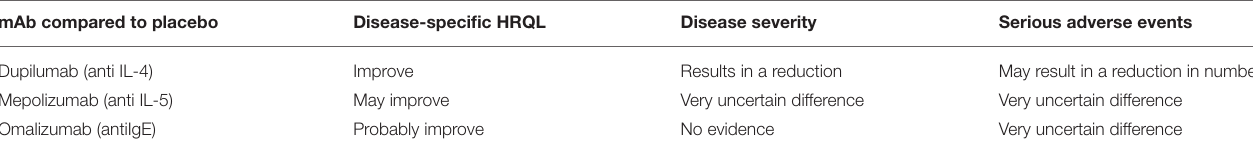
TABLE 2 | Main results of a recent Cochrane Review on the clinical management of patients with NP and CR with biologics. mAb compared to placebo Disease-specific